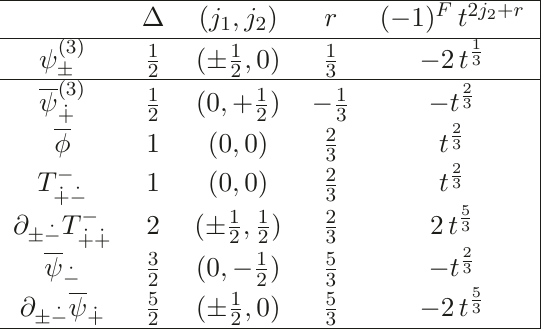
] multiplet. The components of the (anti) self-dual 2